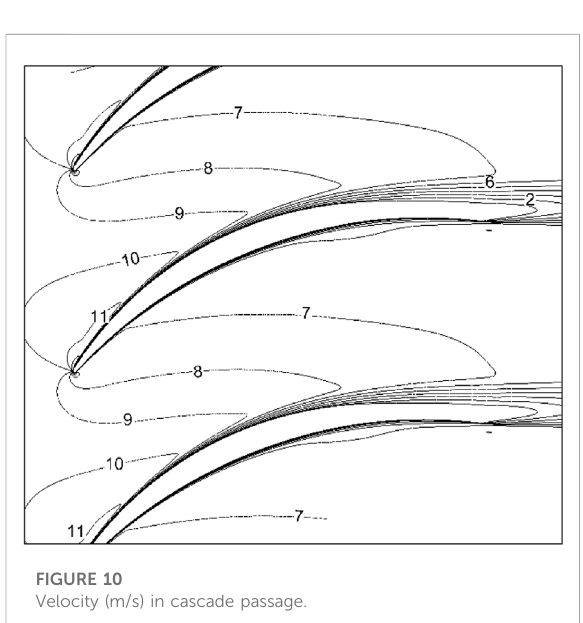
FIGURE 10 Velocity (m/s) in cascade